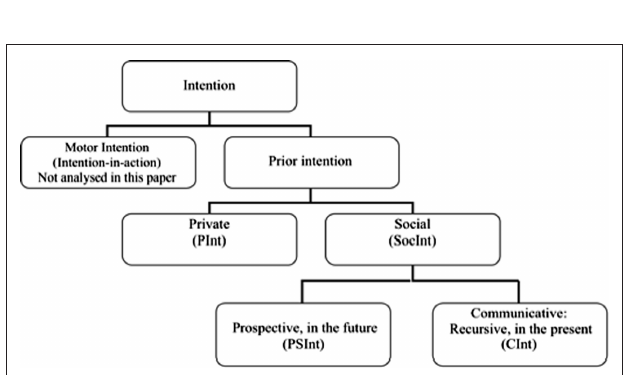
FIguRe 2 | The relation between prior and motor intentions, from third person’s perspective.